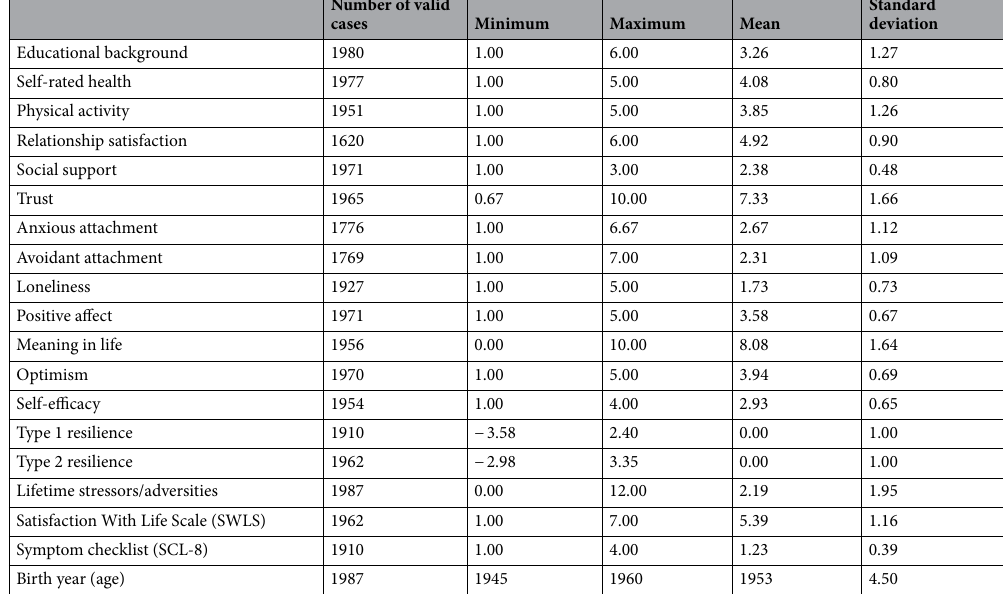
Table 1. Descriptive statistics.